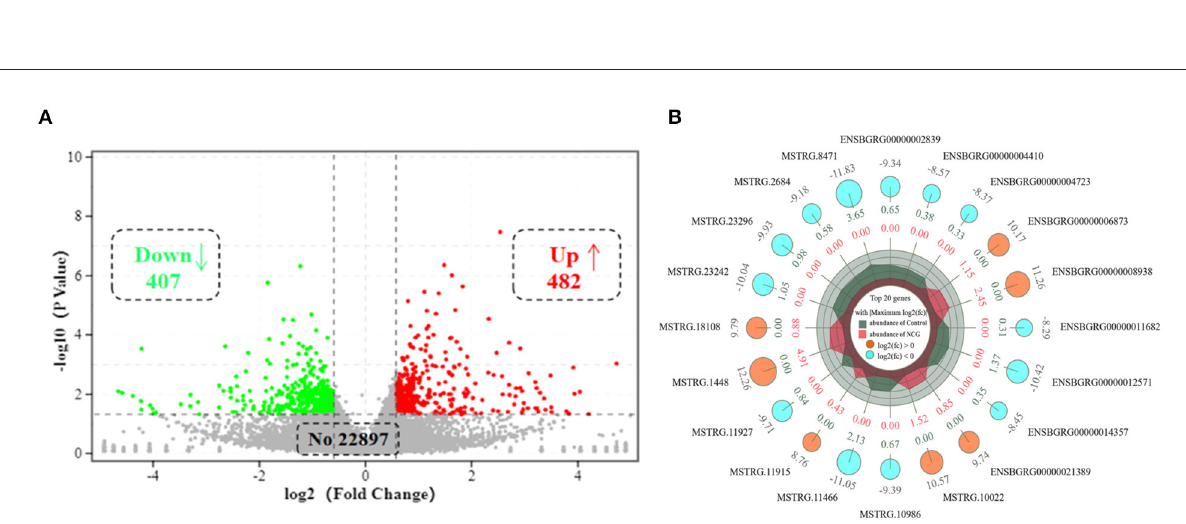
down-regulated in the NCG group (Supplementary Table